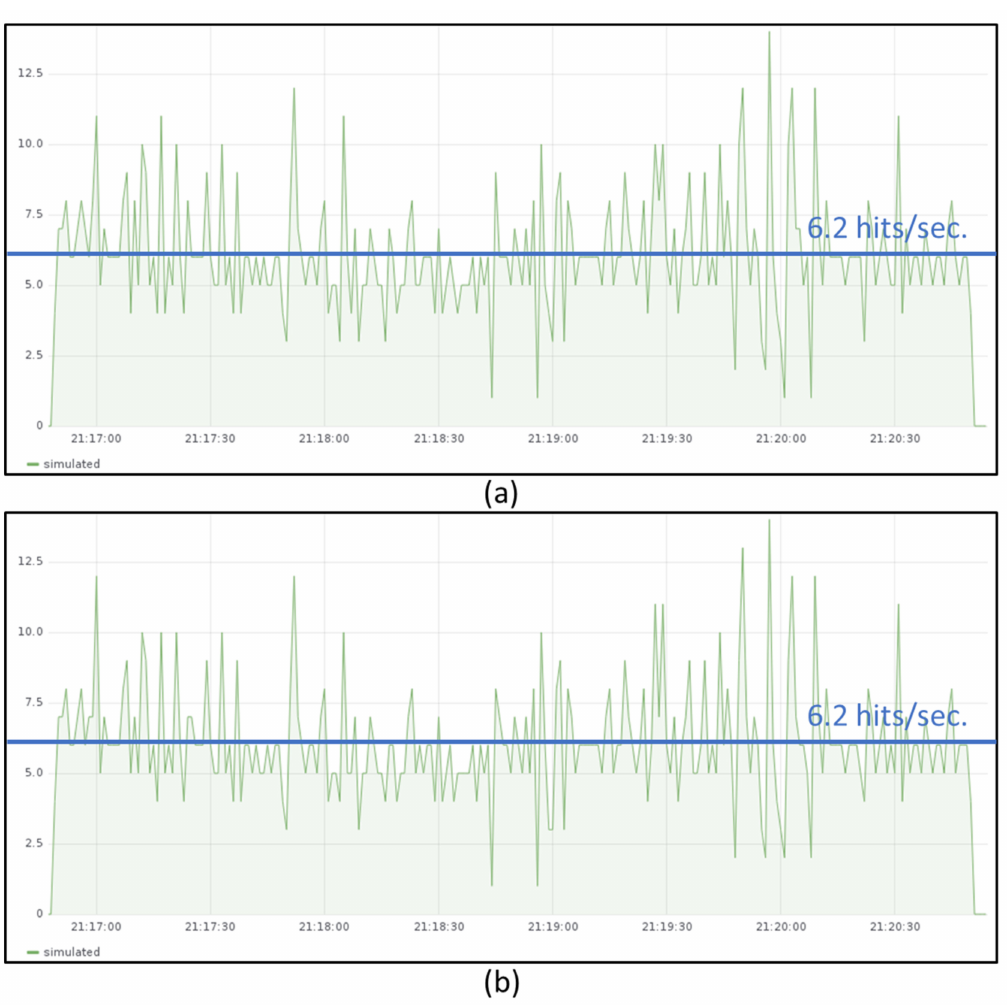
Figure 10. Throughput measured at the IoT gateway ( a ) and the IoT server ( b ) when the gateway is deployed in the Raspberry Pi